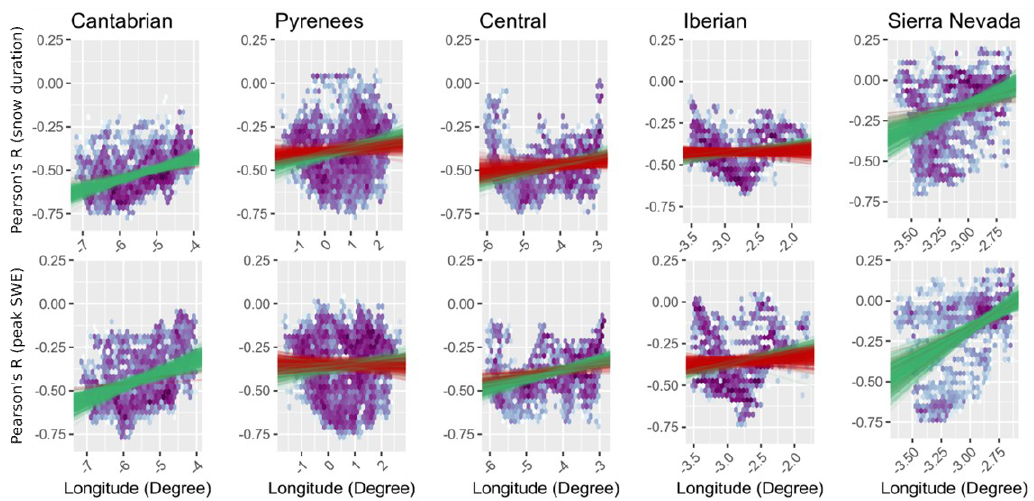
Figure 6. Influence of geographical longitude in the distribution of correlation values for the relationship between the DJFM-NAO and the snow duration and the peak SWE. Red lines indicate no statistical significance of the correlations of the random samples ( p -value > 0.05), while green lines show the statistically significant correlations.